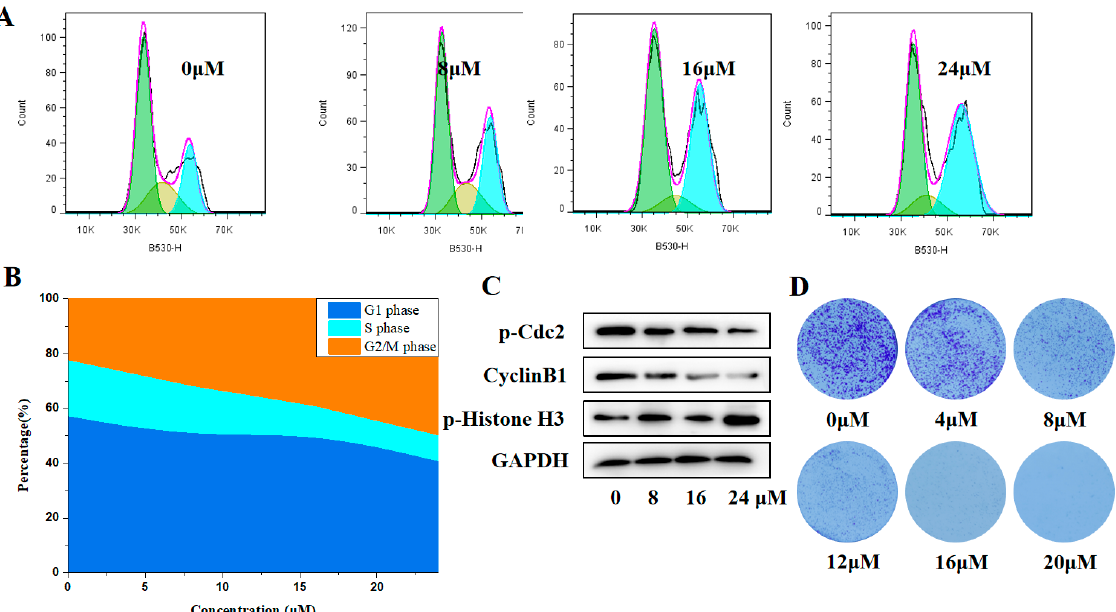
Figure 6. Effects of compound H12 on cell proliferation. For A–C, MGC-803 cells were treated with indicated concentrations of compound H12 for 48 h. For D, MGC-803 cells were treated with indicated concentrations of compound H12 for 7 days. ( A , B ) Cell cycle distribution of treated MGC-803 cells. ( C ) Levels of cell cycle-related proteins in treated MGC-803 cells. ( D ) The colonies that formatted after treatment with compound H12 in MGC-803 cells.